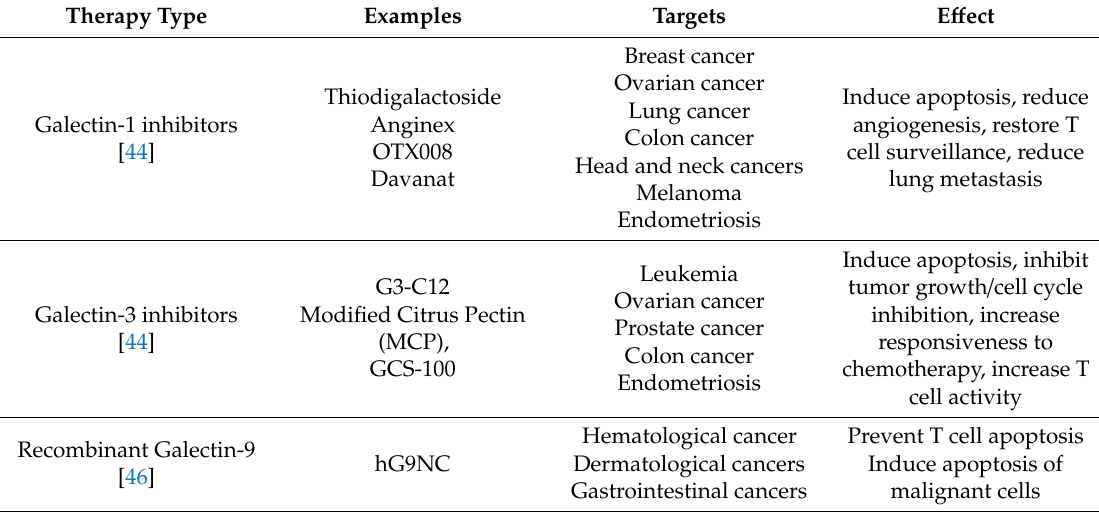
Table 1. Potential clinical uses of galectins in the treatment of cancers and